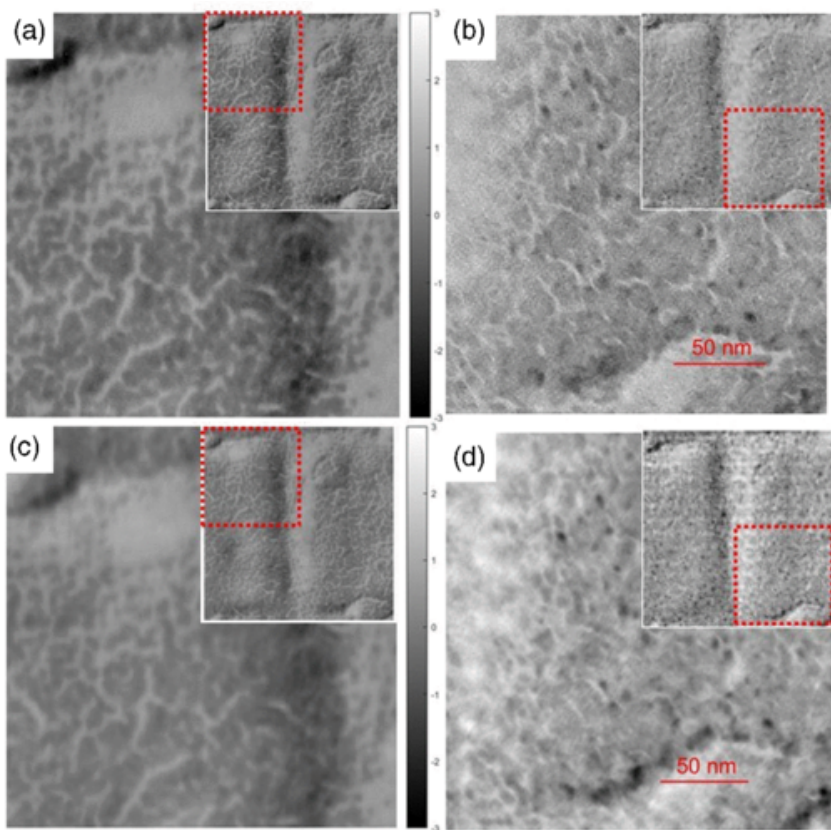
Figure 4. Specimen reconstructions. ( a , b ) The phase and modulus of the specimen when 16 modes were engaged; ( c , d ) The phase and modulus reconstructed with a single mode. The main images are the magnification of the squared area by the red dashed line in the whole field of view inserted in the top corner. Figure adapted from Ref [14]. Reprint permission granted. 2016 American Physical